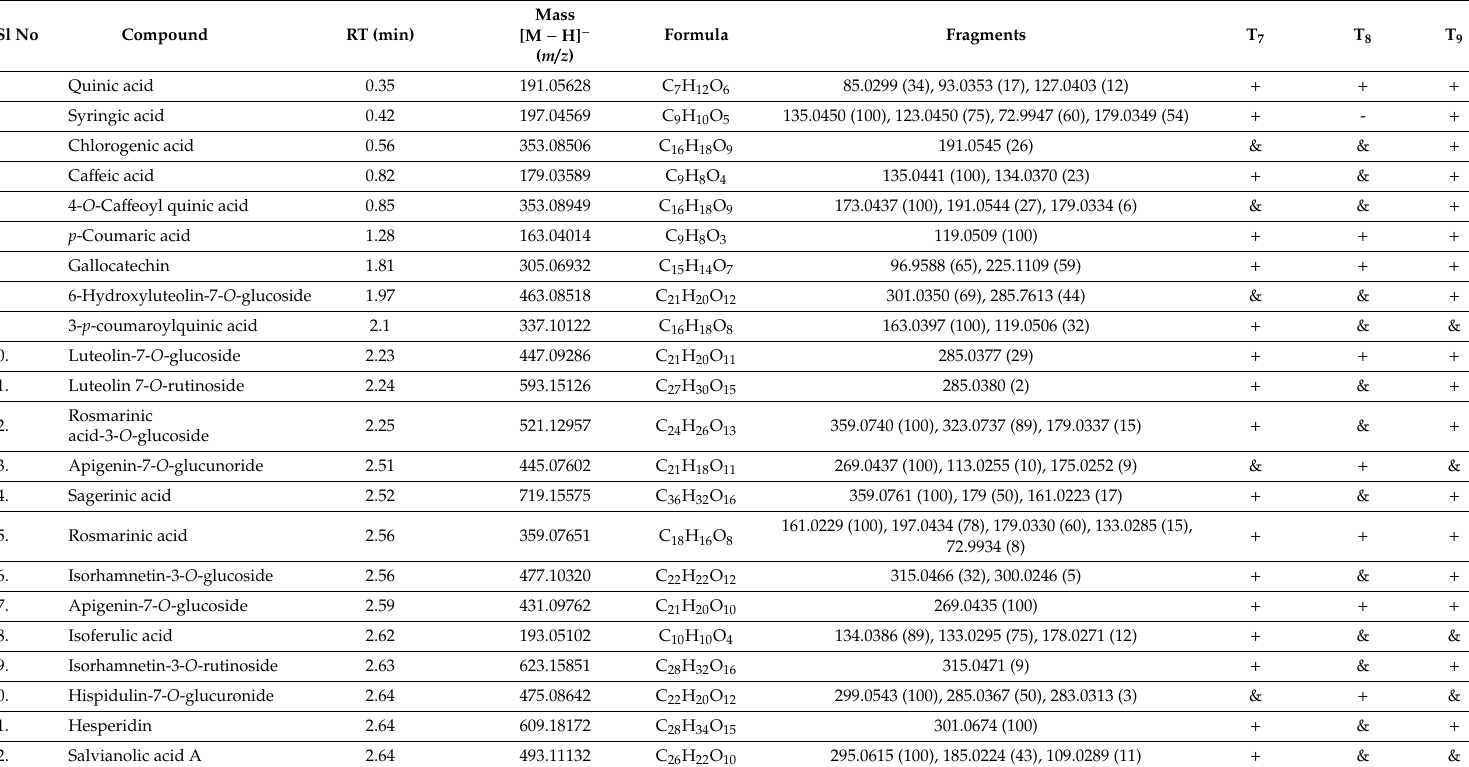
Table 4. Analysis of bioactive constituents by UHPLC-ESI-QTOF-MS in Soxhlet extract (T 7 ) and sonicated extracts (water and methanol—T 8 and T 9 ) of R. o ffi